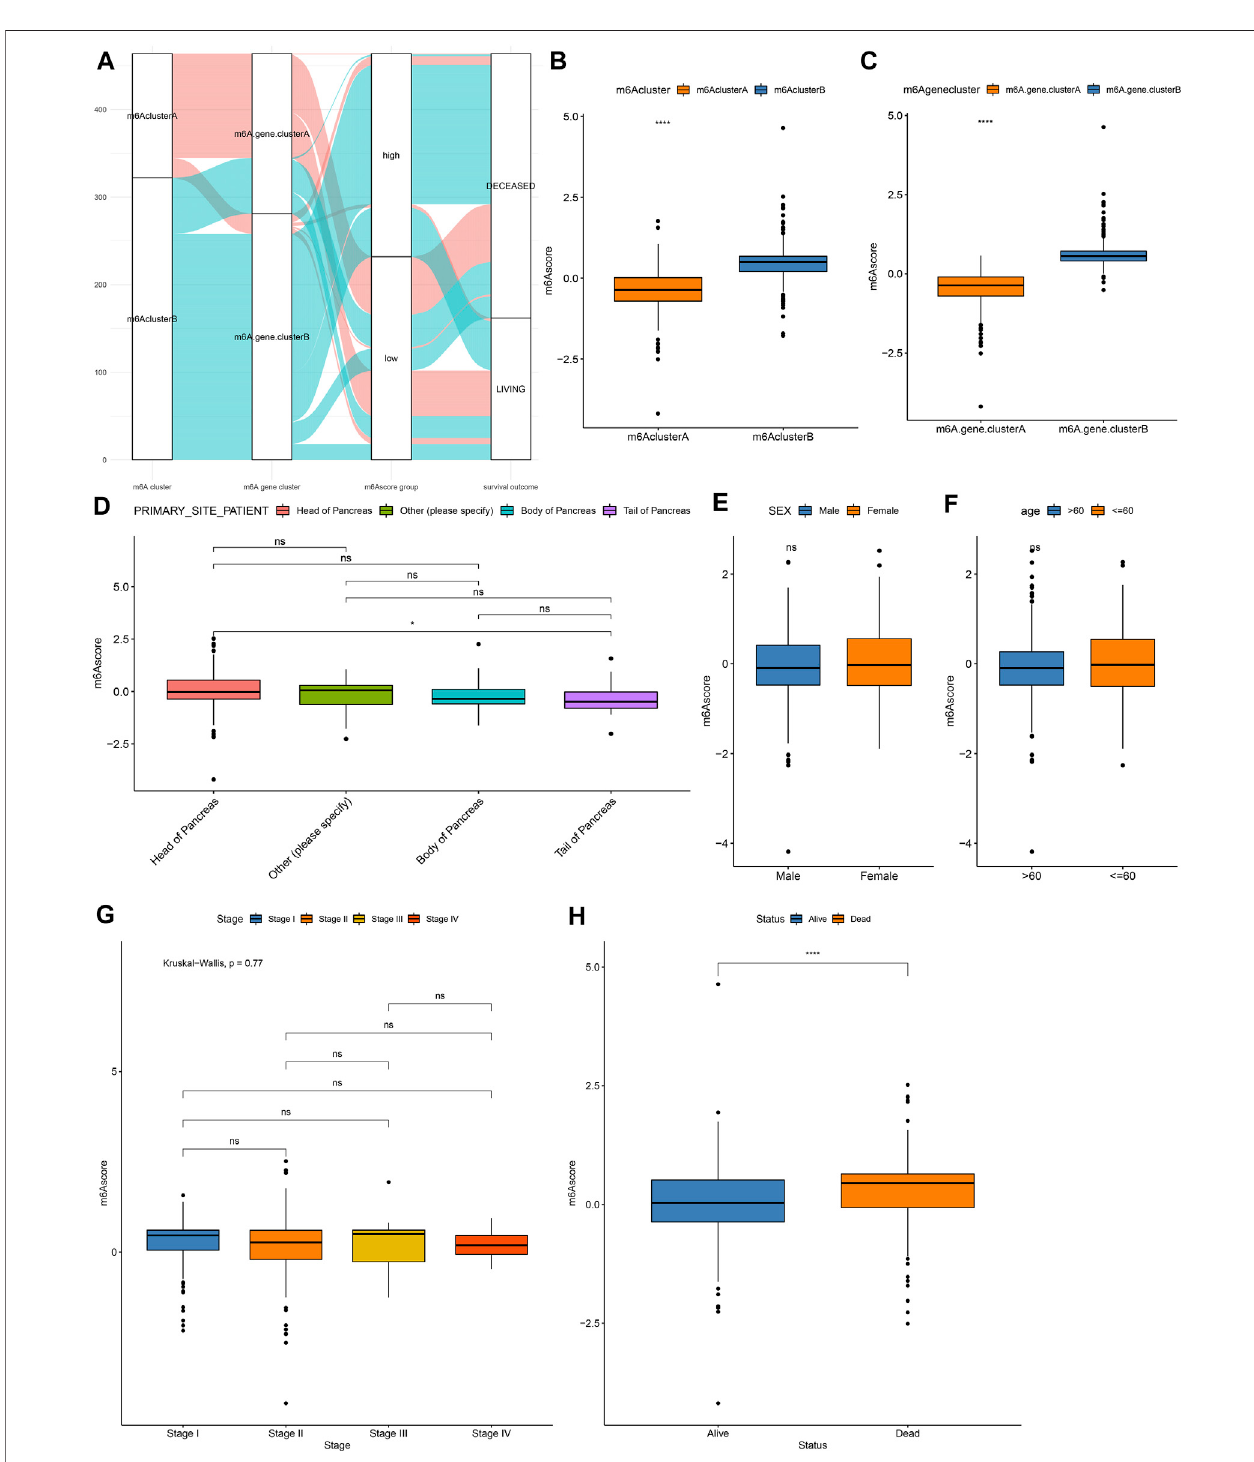
FIGURE 5 | Development of a m 6 A scoring system in pancreatic cancer. (A) Alluvial diagram for the relationships of m 6 A modi fi cation patterns, m 6 A gene clusters and m 6 A scores. (B) Distribution of m 6 A scores in m 6 A cluster A and B. (C) Distribution of m 6 A scores in m 6 A gene cluster A and B. Distributions of m 6 A scores in (D) different primary sites, (E) sex, (F) age, (G) stage, and (H) survival status. Ns: not signi fi cant; **** p < 0.0001.